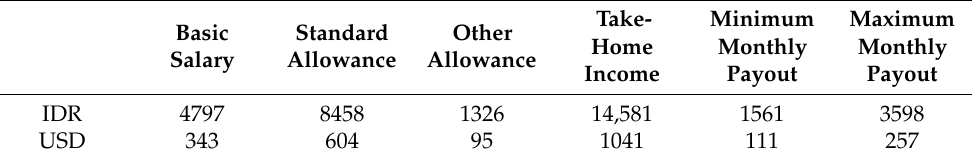
Table 3. Take-home income and monthly retirement payout of Head of Section, III/d based on the existing system, 2020 (in thousand